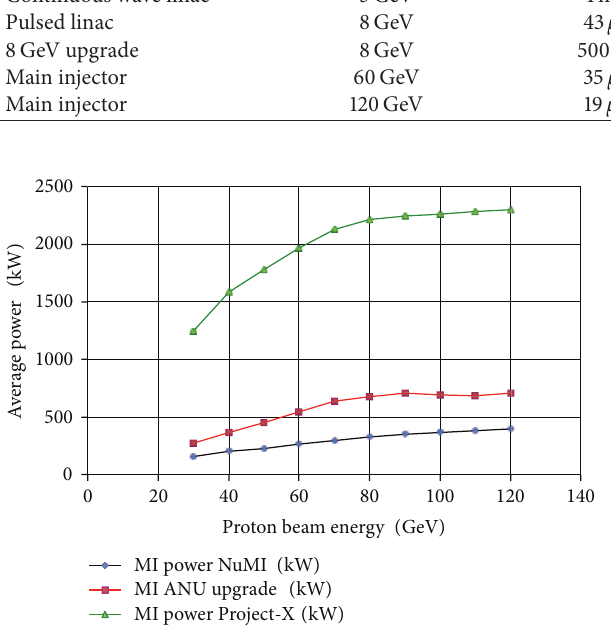
Figure 7: Proton beam power as a function of proton energy from theFermilabMainInjector. Shownarecurrentcapabilitieslabeledas NuMI. The recently funded upgrades (labeled as ANU) will increase the power to 550 kW at 60GeV or 700 kW at 120GeV. Project-X as currently conceived will allow beam power of 2 MW at 60GeV and 2.3 MW at 120 GeV.